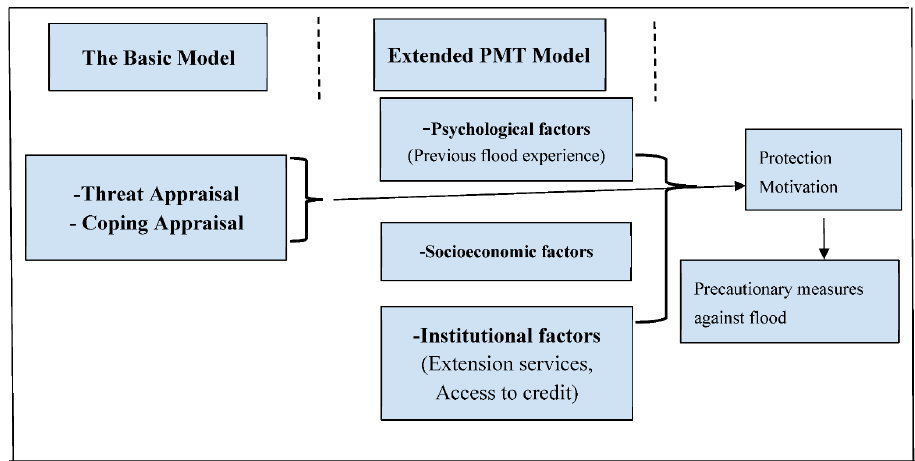
Figure 1. Protection motivation theory (Authors’ own edition based on Twerefou [29]).